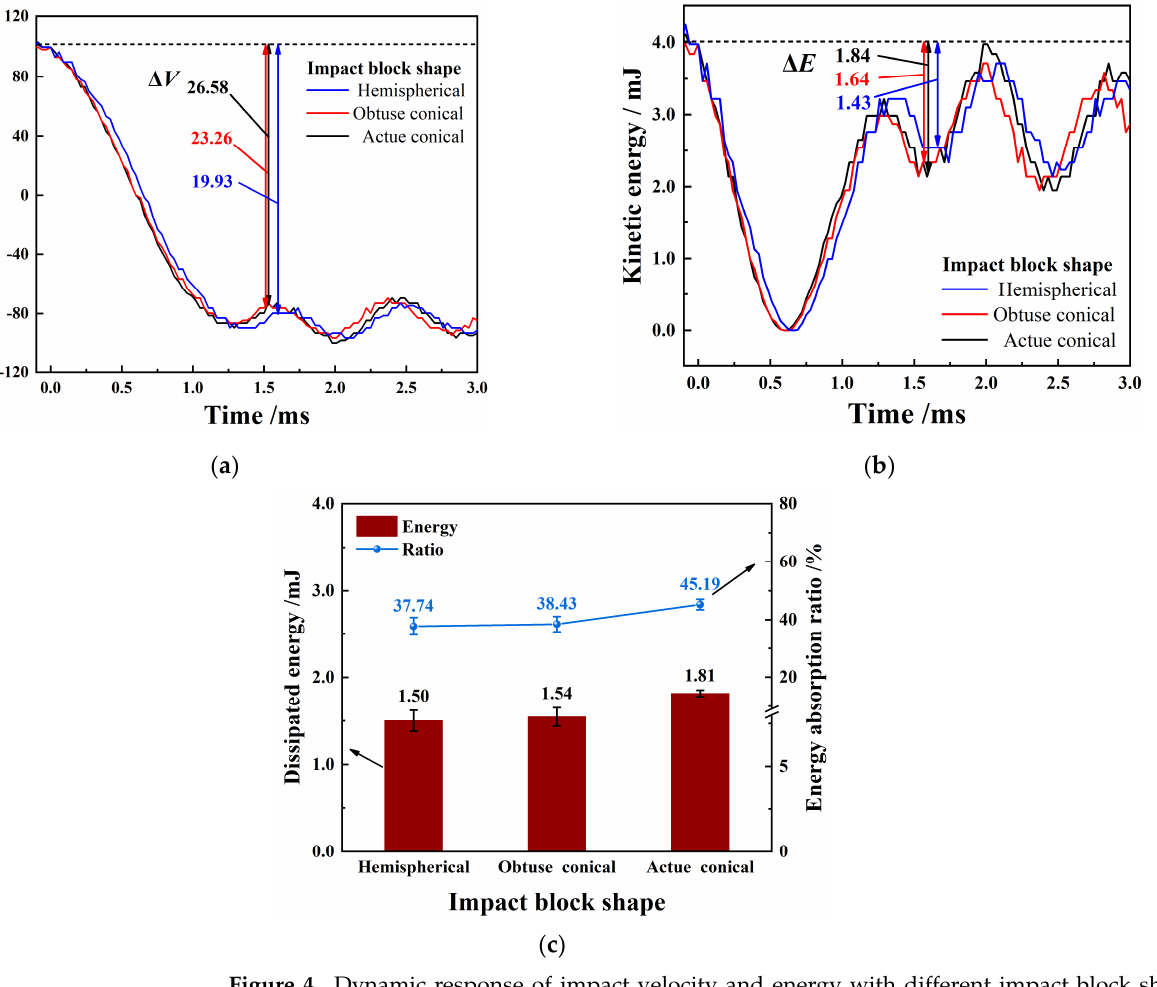
Figure 4. Dynamic response of impact velocity and energy with different impact block shapes, N = 5 × 10 5 . ( a ) Impact velocity response vs. time; ( b ) impact energy response vs. time; ( c ) absorbed energy evolution. The dotted lines in ( a , b ) represent the initial impact velocity of 100 mm/s and the initial impact energy of 4.0 mJ for different impact block shapes.